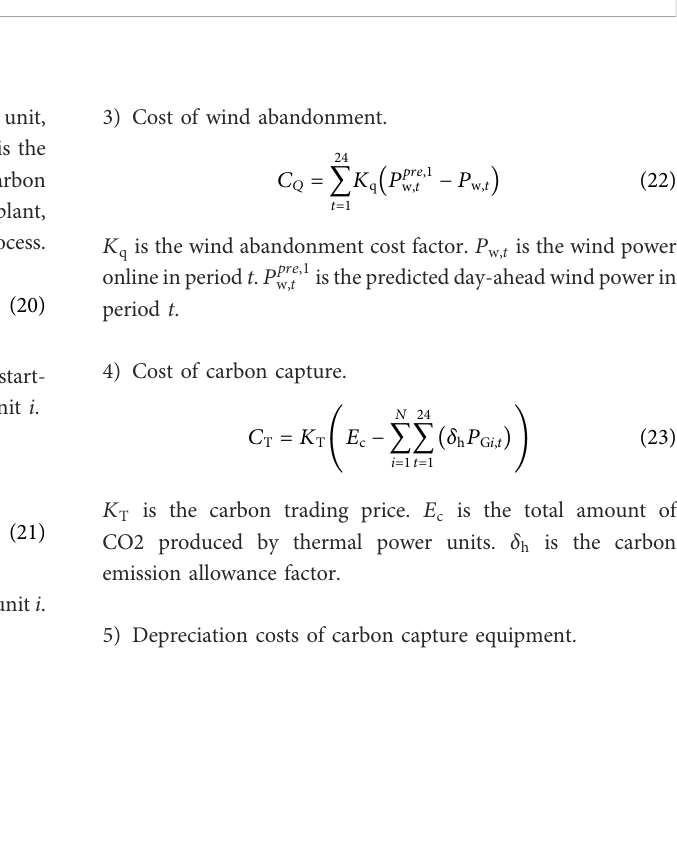
FIGURE 9 Low carbon economic dispatch framework for systems considering multi-time scale wind power